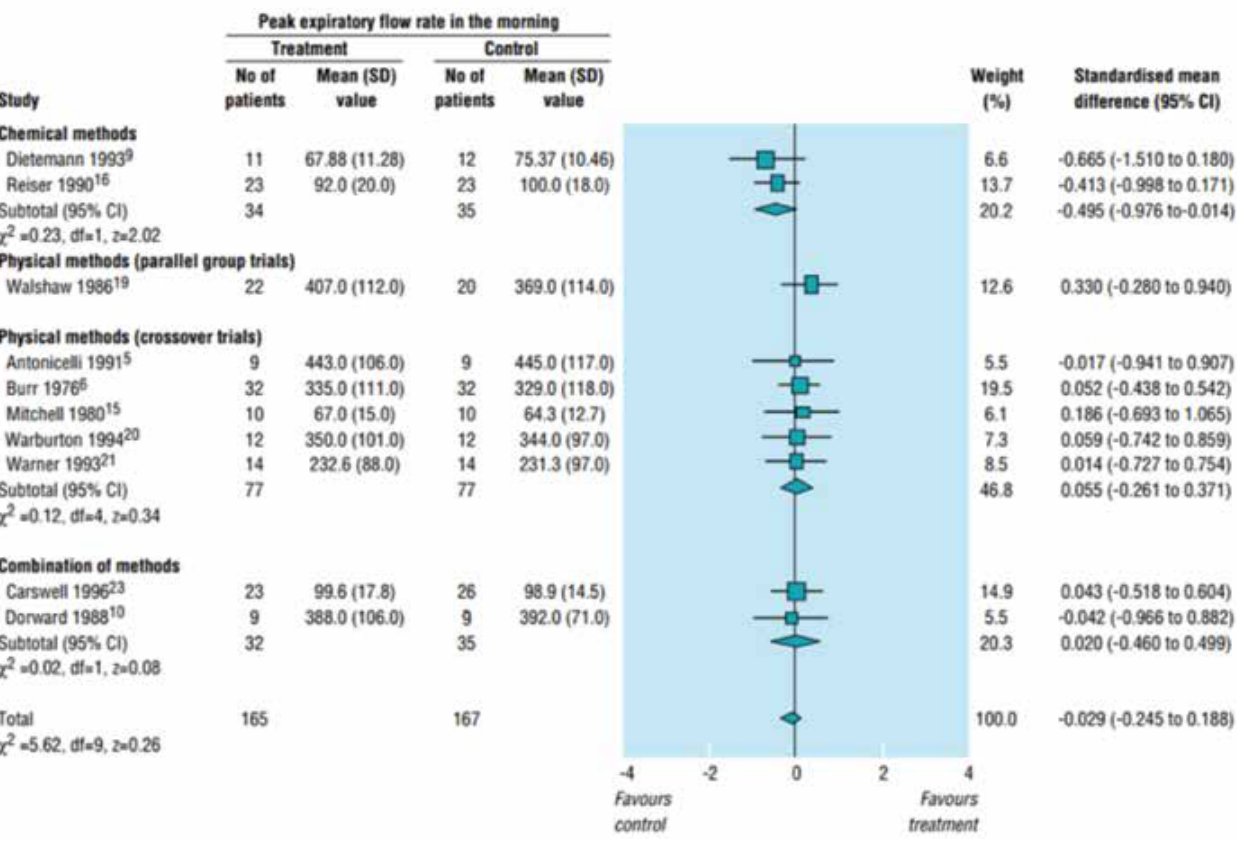
Figure 1 : Standardised mean difference (95% confidence interval) of peak expiratory flow rate in the morning after the use of either chemical or physical methods to reduce exposure to house dust